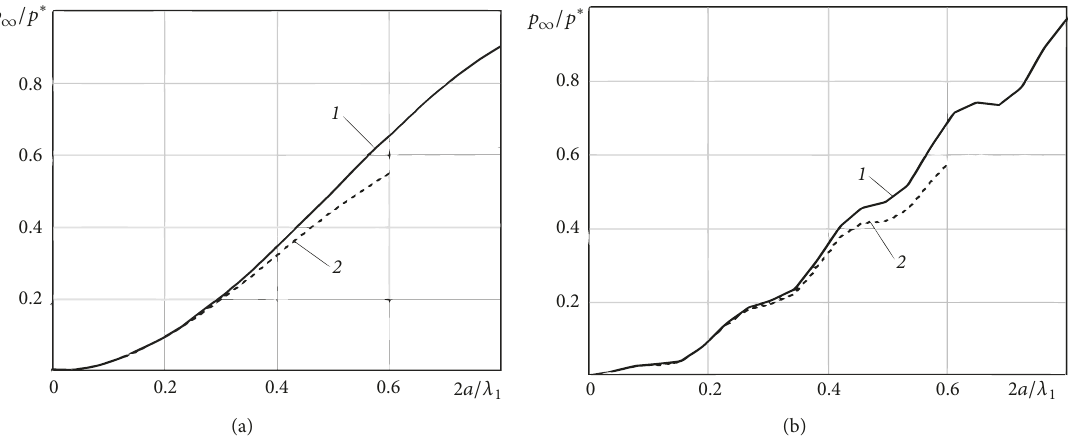
Figure 4: Graphs of dimensionless mean pressure as a function of dimensionless contact length ( 𝜆 1 = 2 𝜋 , Δ 1 = 0.5): f ( x ) = Δ 1 cos (𝑥) (a); f ( x ) = Δ 1 cos (𝑥) +0.02 Δ 1 cos (11 x ) (b); 1 – periodic solution, 2 – nonperiodic